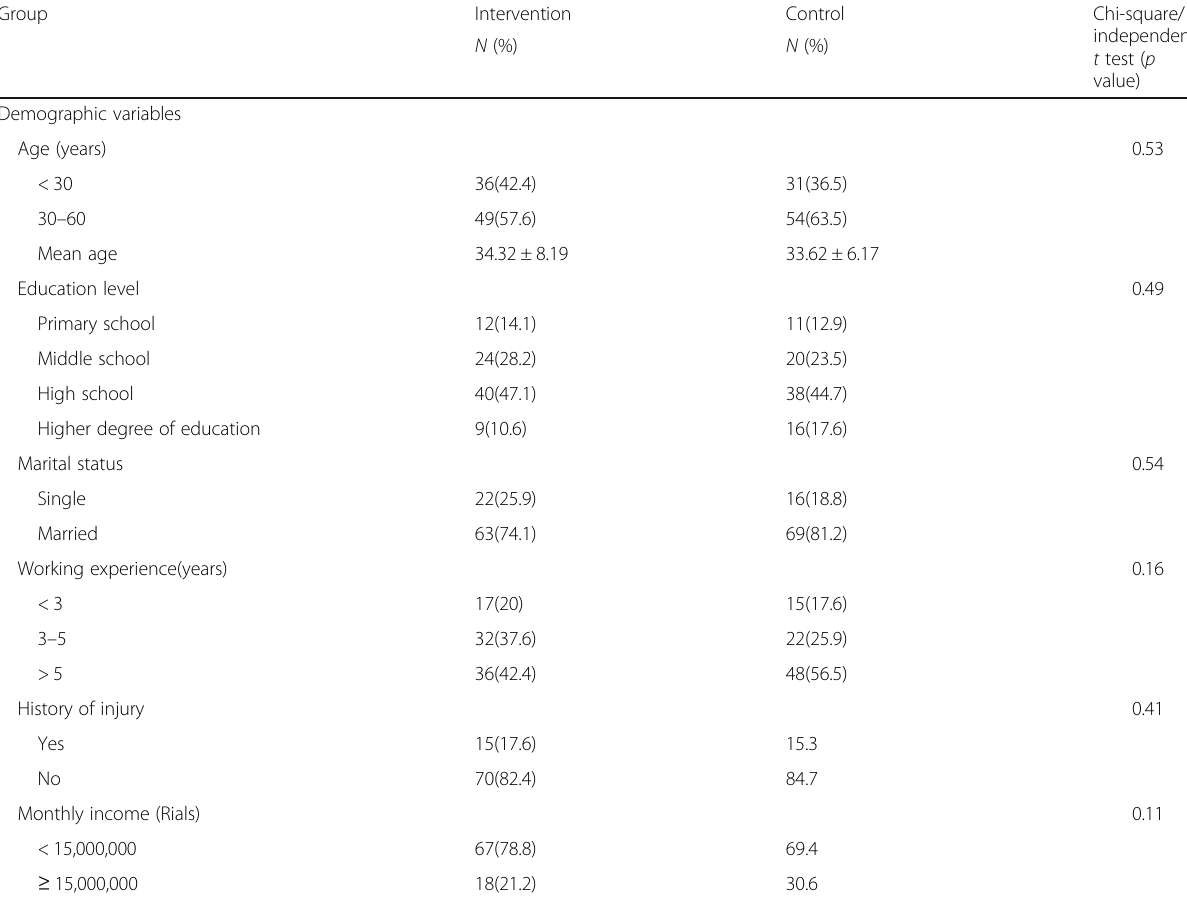
Table 2 Frequency distribution of demographic characteristics of the intervention and the control groups of workers in two cement factories in Khoy and Urmia, Iran, 2016 Group